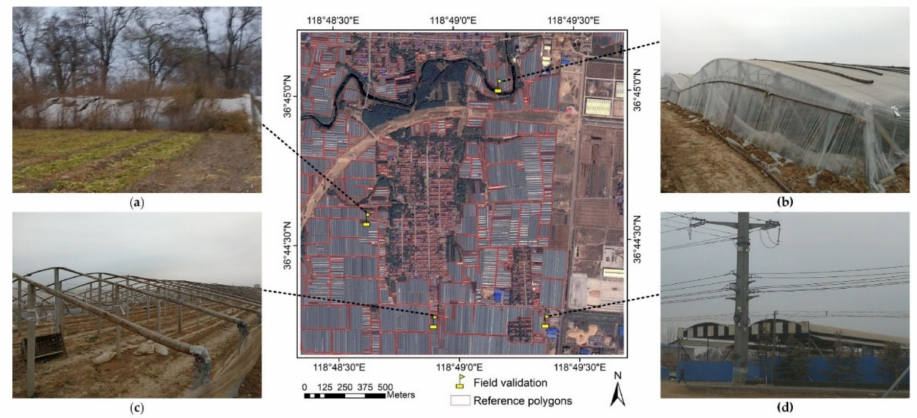
Figure 2. GF-2 image, reference polygons and ground verification photos of the experimental area: ( a ) PG with walls; ( b ) PGs without walls with higher reflectance in image; ( c ) unsheathed PGs without walls; ( d ) other sheds used for storage. Table 2. Band no., spectral range, spatial resolution, and bit depth of GF-2 images. Image Type Band No. Spectral Range ( µ m) Spatial Resolution (m) Bit Depth